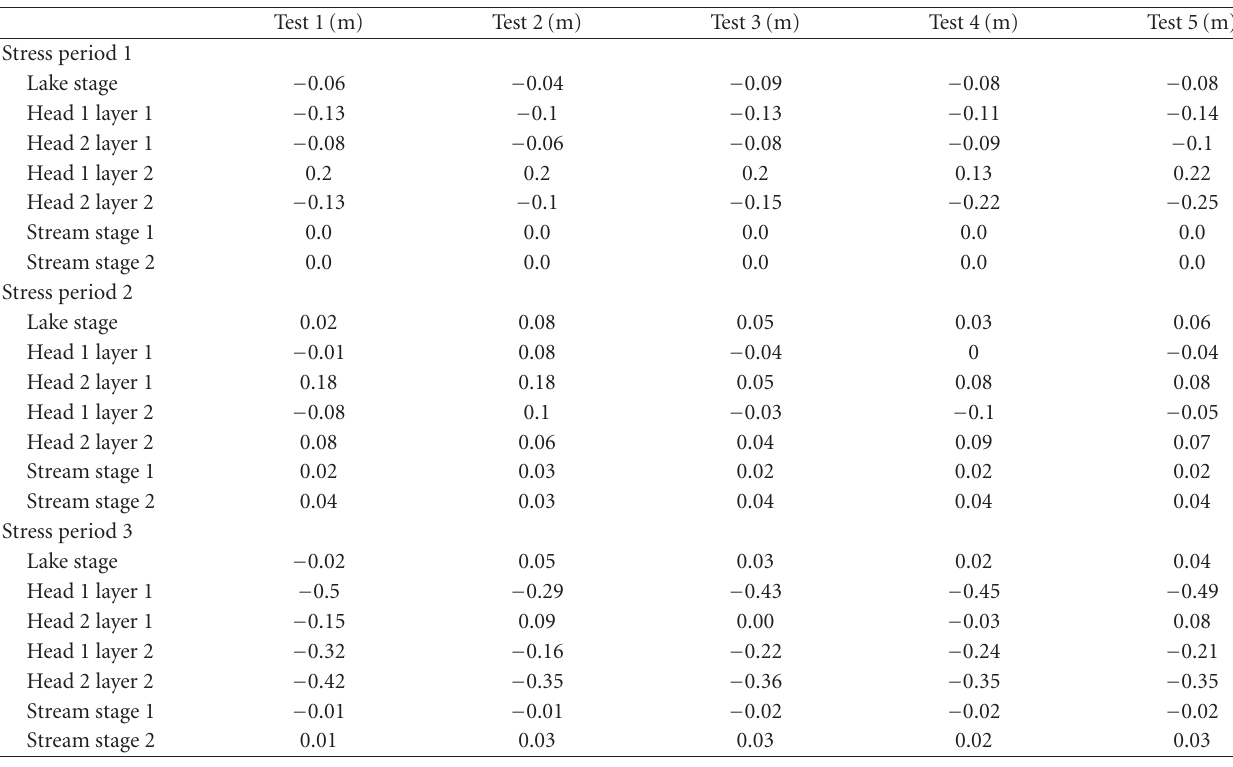
Table 6: Residual errors (MODLAKE minus ANN-GA) for five tested strategies.